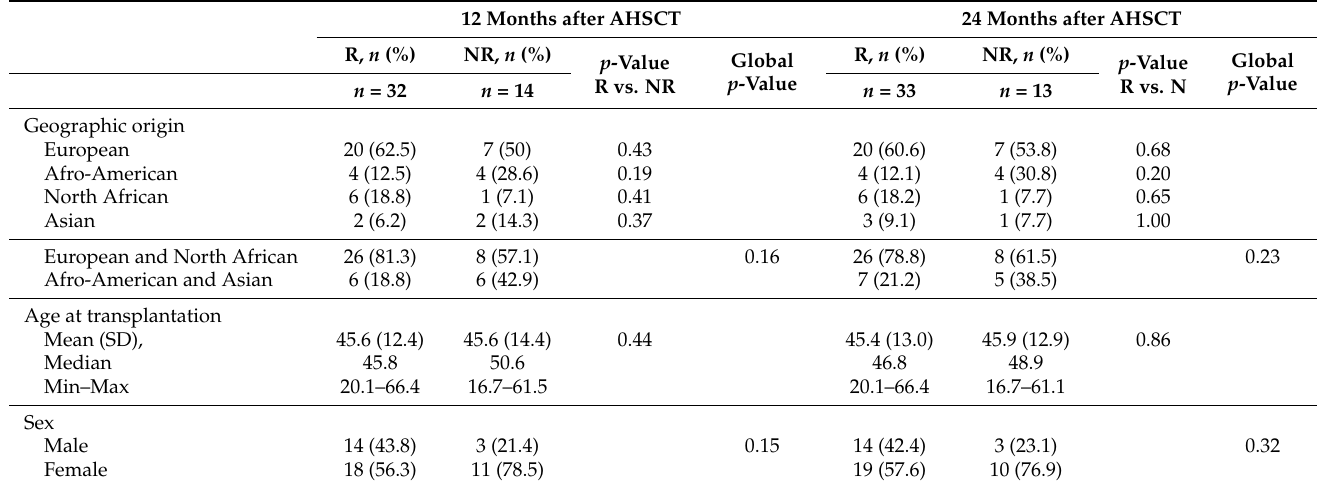
Table 2. Demographic characteristics of 46 Systemic Sclerosis patients, according to the observed clinical response (responder or non-responder) at 12 and 24 months after autologous hematopoietic stem cell transplantation (AHSCT).